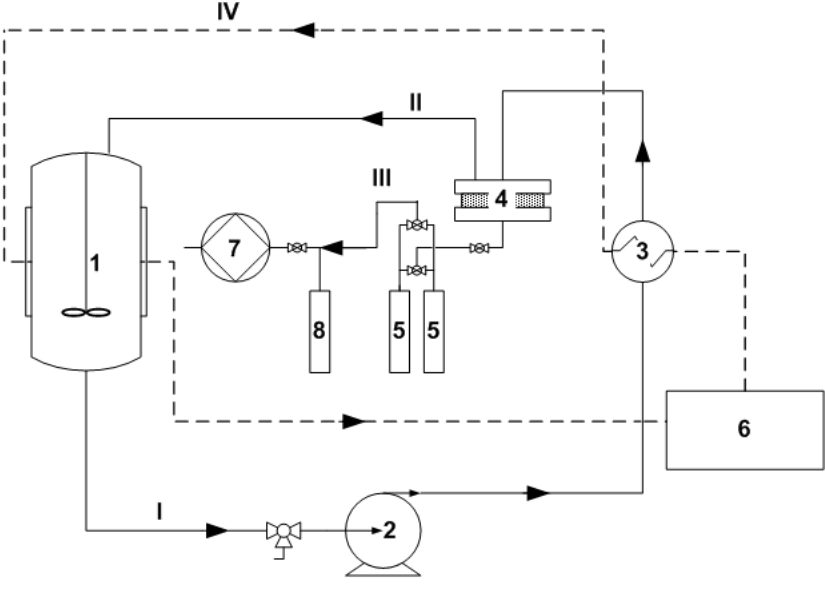
Figure 2. Layout of the vacuum pervaporation setup.